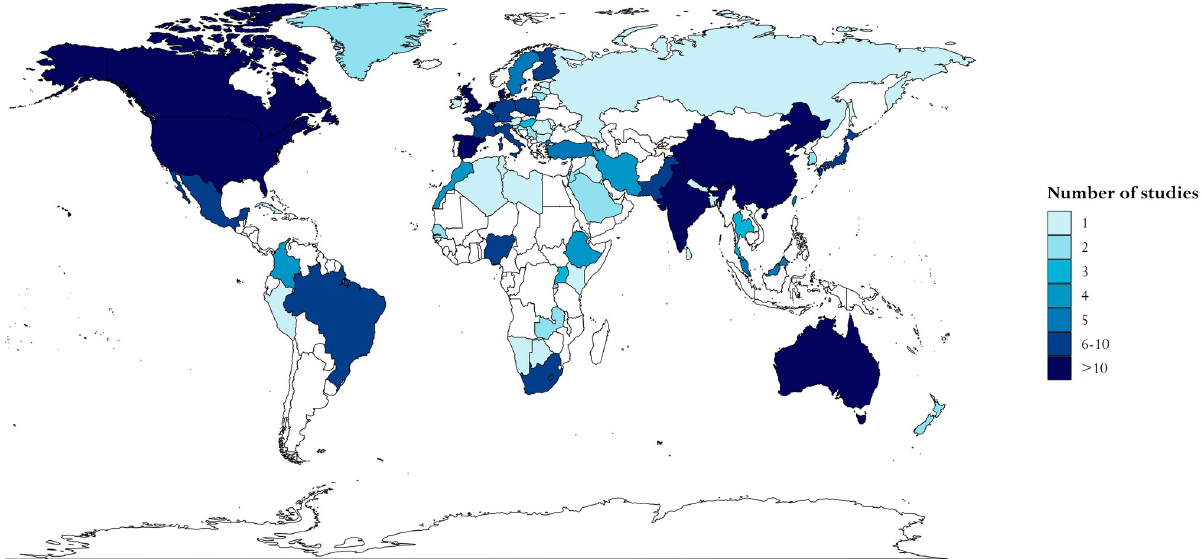
Fig 2. Choropleth map of countries represented in the systematic review according to the number of studies in which each country is represented. The base layer map is obtained in R via ggplot2::map_data(“world”), which imports the world map from Natural Earth, which is in the public domain and available from https://www.naturalearthdata.com, with terms of use available in http://www.naturalearthdata.com/about/terms-of-use/.